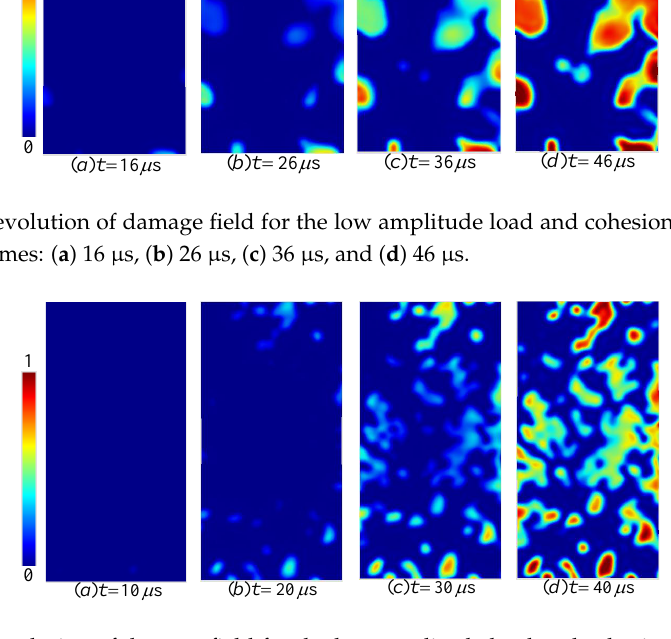
Figure 14. The evolution of damage field for the low amplitude load and cohesion realization with l c = 5 mm at times: ( a ) 10 µ s, ( b ) 20 µ s, ( c ) 30 µ s, and ( d ) 40 µ